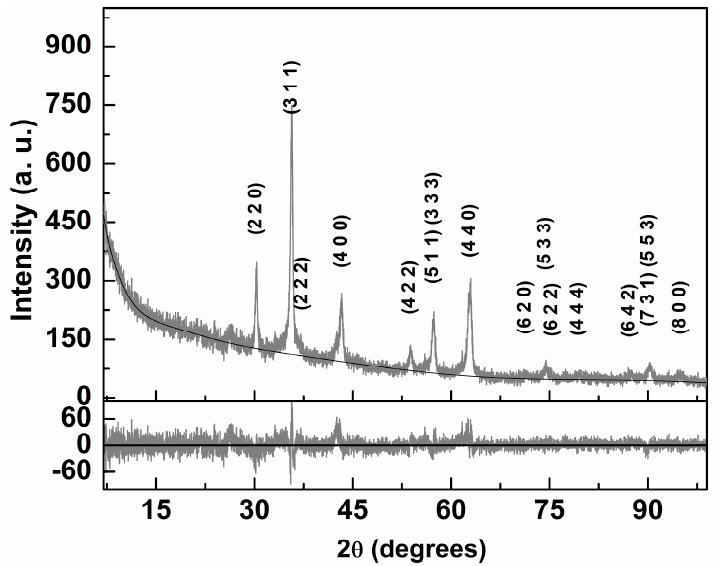
Figure 2. X-ray diffractogram of calcined Mg 0.75 Ca 0.25 Fe 2 O 4 nanoparticles and corresponding Rietveld analysis with Miller indices. Bottom panel: Residuals of the fitting procedure.